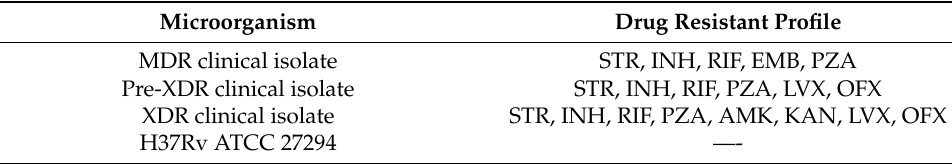
Table 3. Antibiotic resistance profile of M. tuberculosis